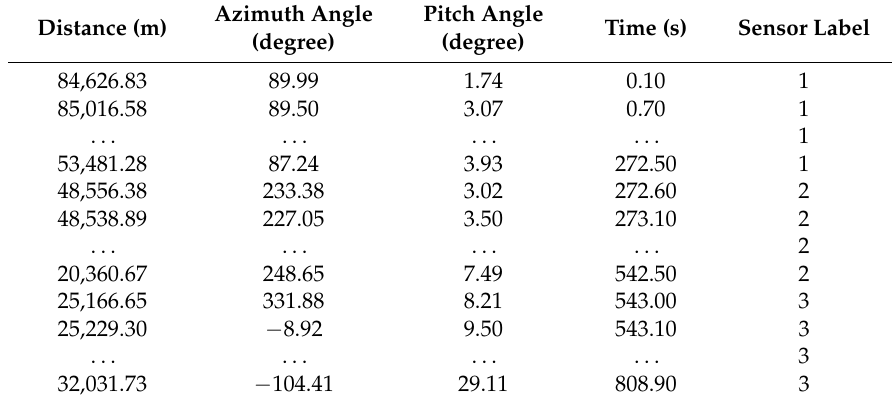
Table 1. Part of the measurement data of two targets measured with three sensors.